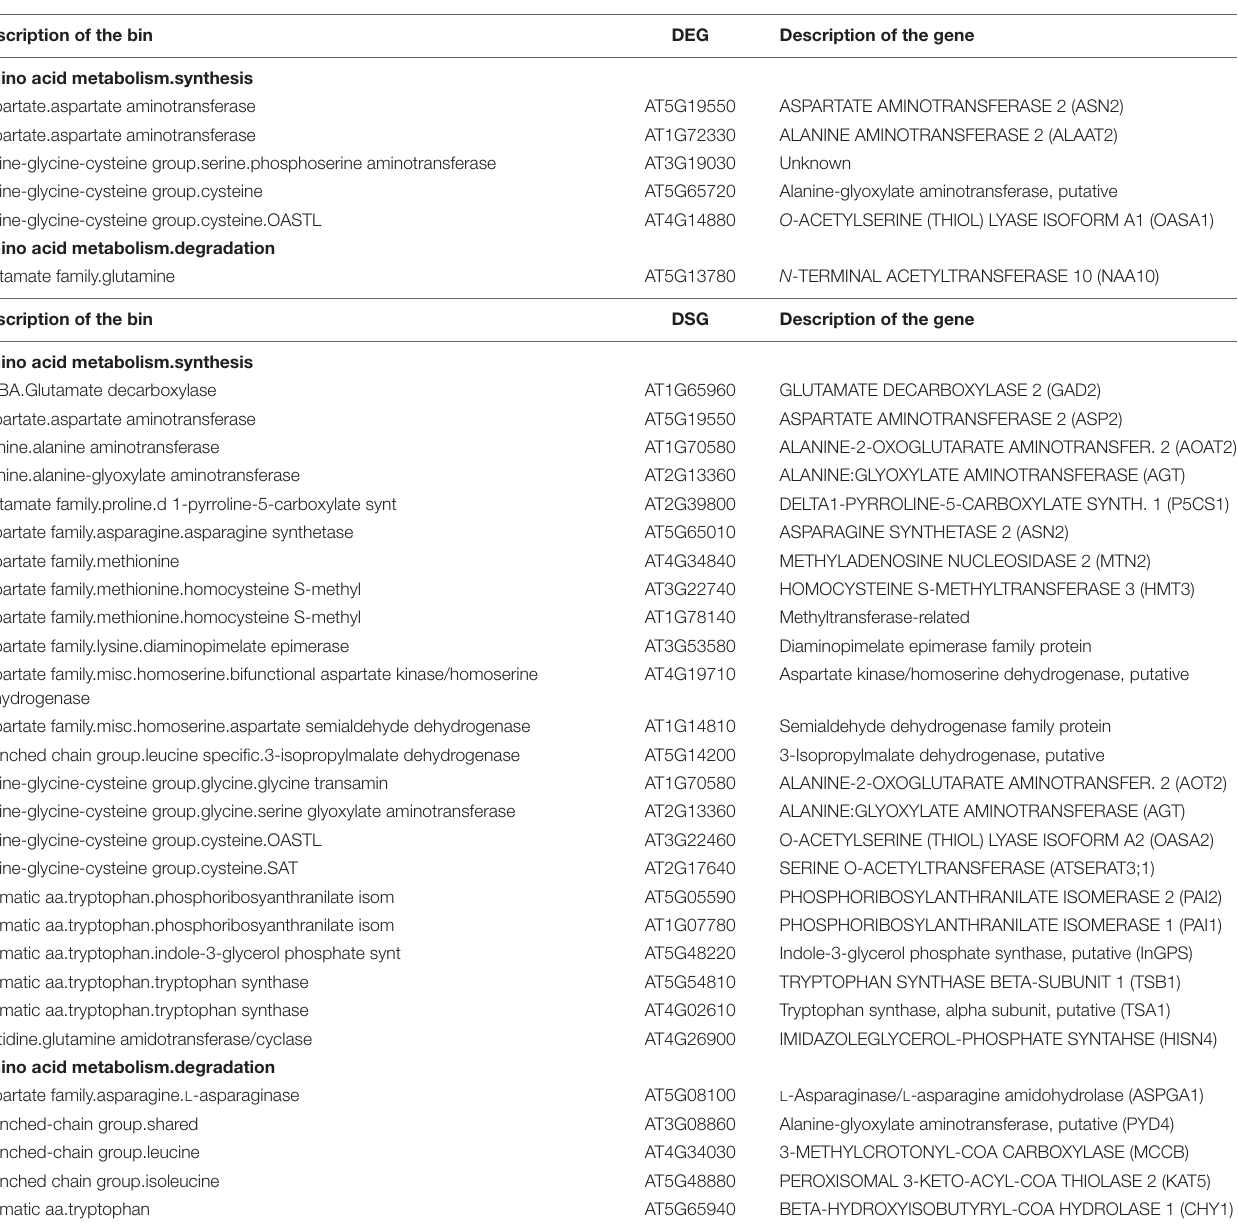
TABLE 1 | Identified Mapman bins related to amino acid metabolism. Description of the